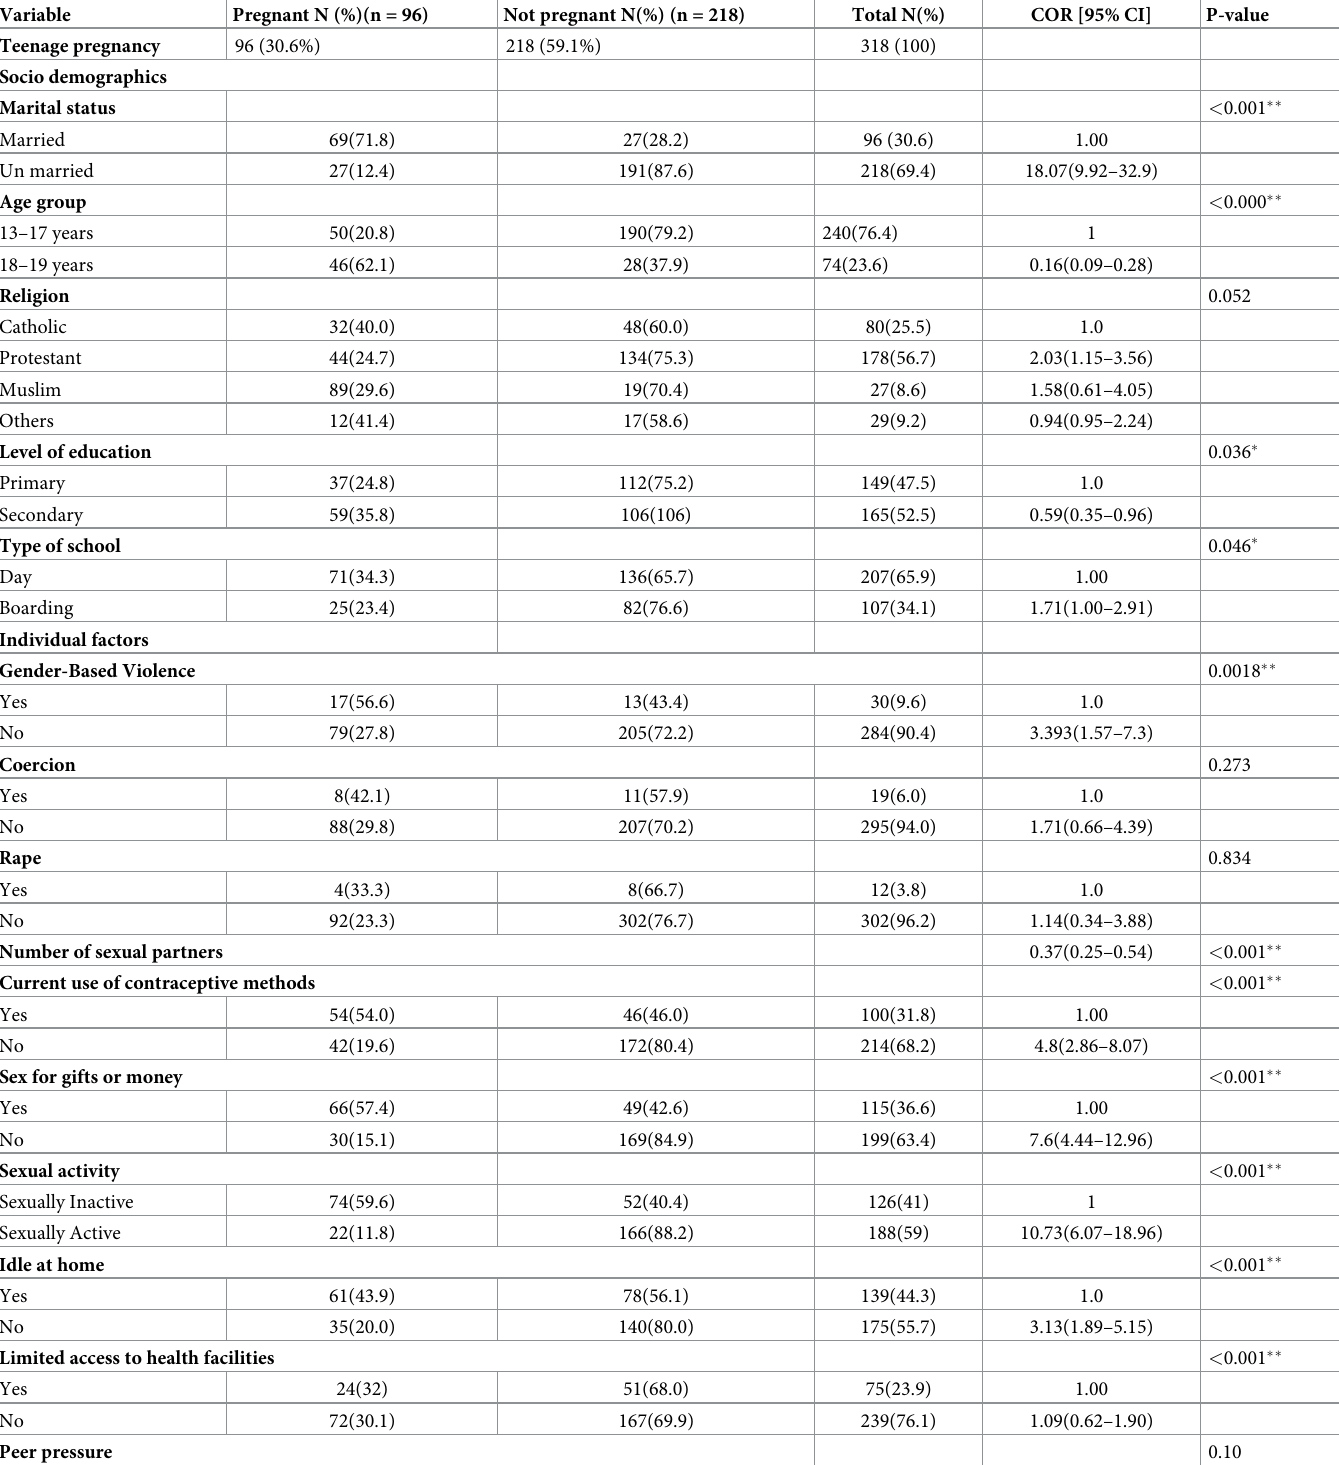
Table 1. Prevalence of pregnancy and its associated factors among the teenage girls aged 13–19 years in Hoima district western Uganda during the COVID-19 pan- demic in